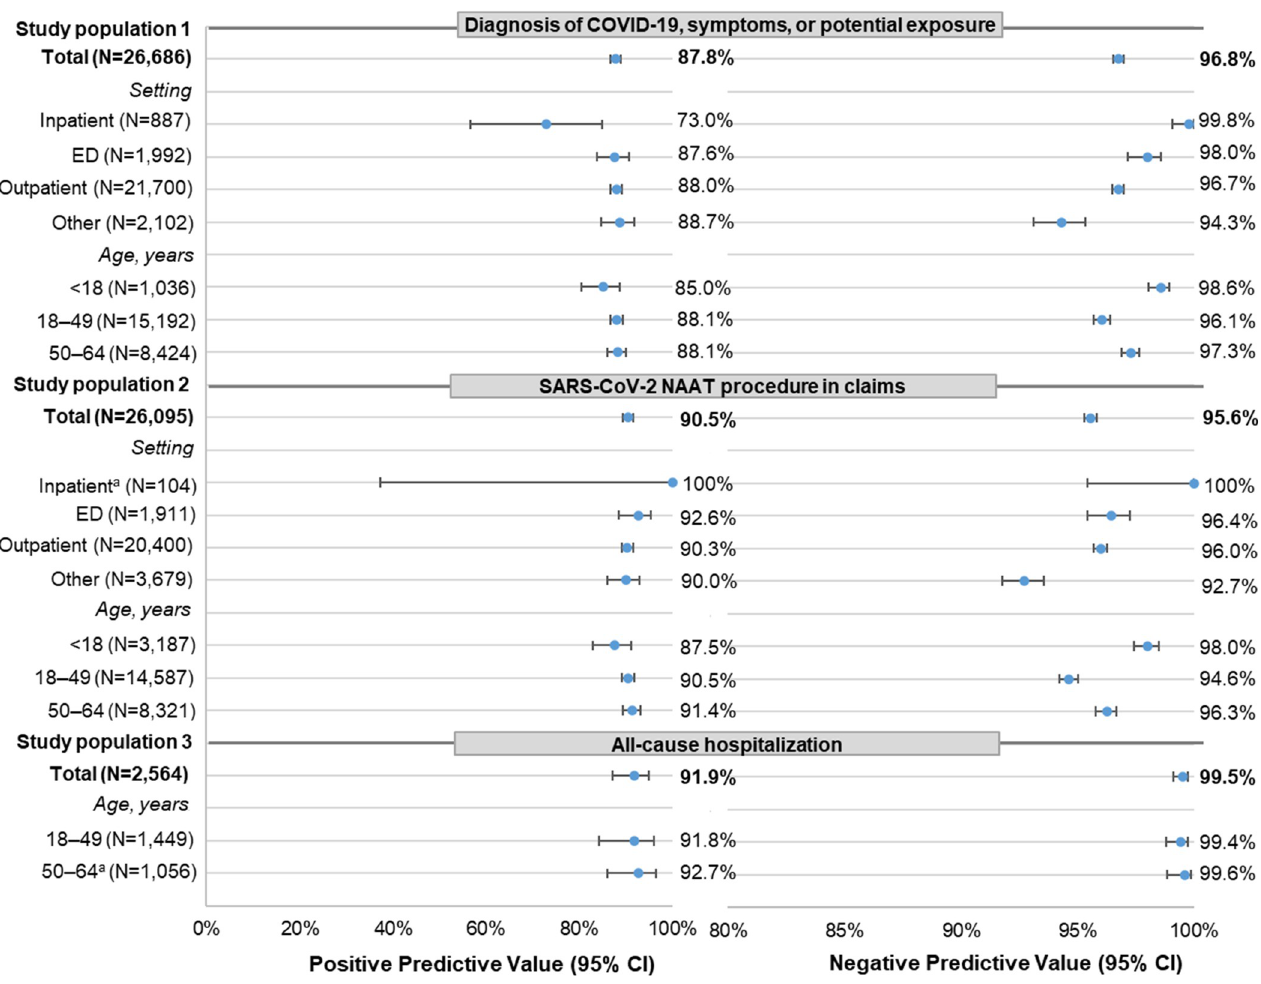
Fig 4. Performance characteristics (PPV/NPV) of diagnosis code U07.1 in claims data among commercially insured individuals. The PPV and NPV are not calculated for children < 18 years old in study population 3 because the cell size was � 1 in three cells of the 2X2 table for the calculation of PPV and NPV. Care setting and age were measured at the index event. Outpatient encounters include physician office, ambulatory care, outpatient hospital, and urgent care visits. Care setting was defined using a hierarchy if services at multiple settings were found on the index event date: inpatient, ED, outpatient, other. See S2 Table 2A in S2 File for the full results with exact CIs. The PPVs for study population 1 (inpatient setting at index event) and population 3 (all-cause hospitalization) are different because study population 1 episodes include diagnoses outside the hospitalization. CED IBM MarketScan Explorys